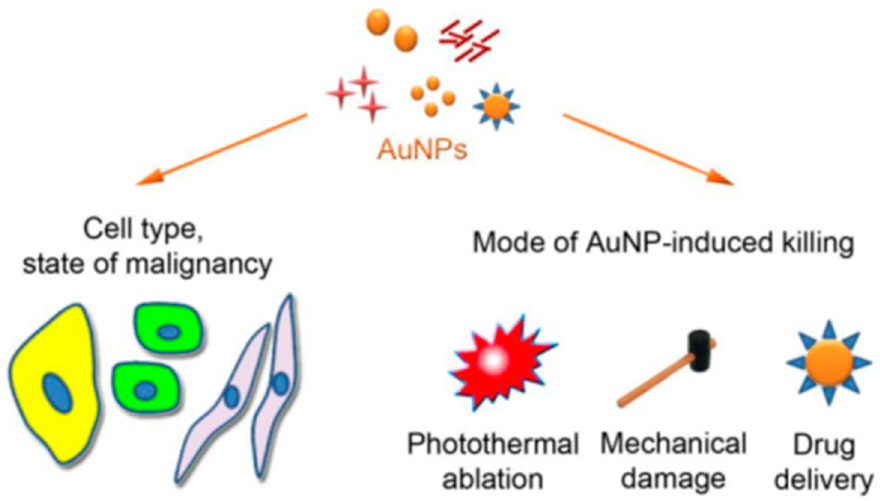
Figure 1. Depicting the cytotoxic impact of gold nanoparticles on tumor cells. This picture represents three of the major mechanism of cytotoxicity conferred by gold nanoparticles-photothermal damage, mechanical damage and drug delivery. Gold nanoparticles (GNPs) are referred as AuNPs here.